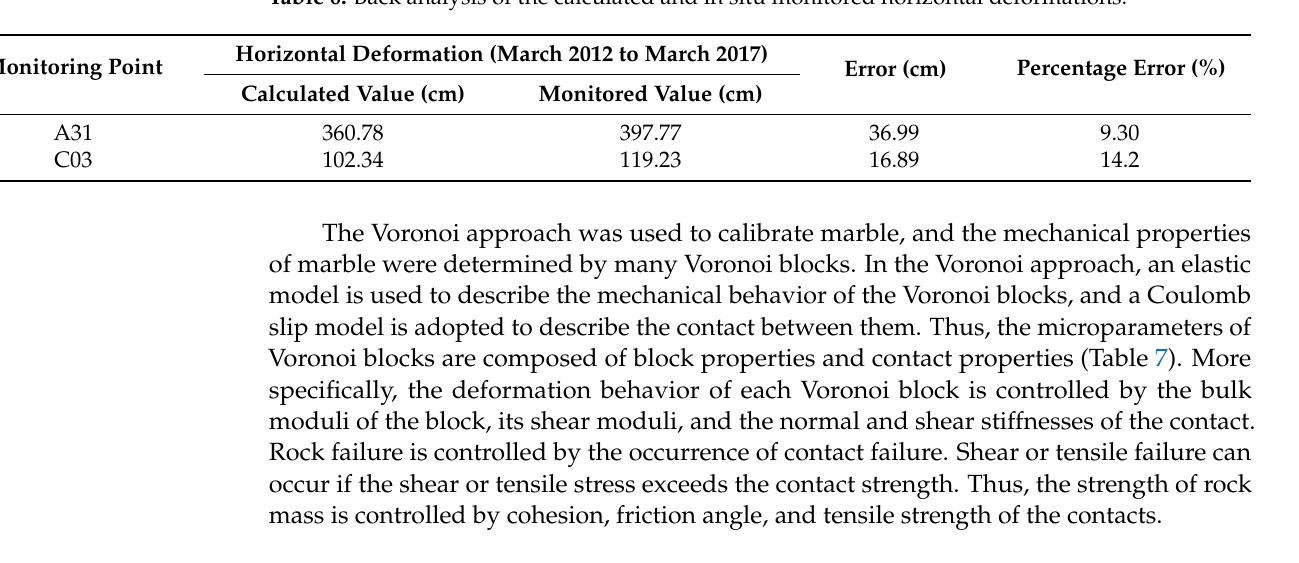
Table 7. Microparameters used in the UDEC Voronoi model used to describe the